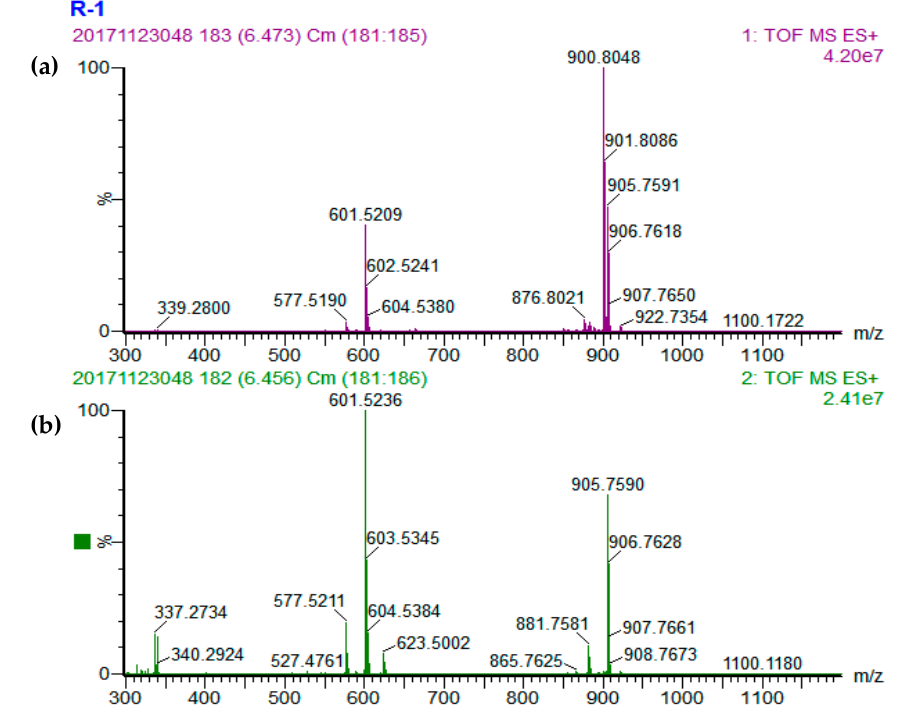
Figure 3. MS spectra of O-L-O. ( a ) MS 1 spectrum and ( b ) MS 2 spectrum.